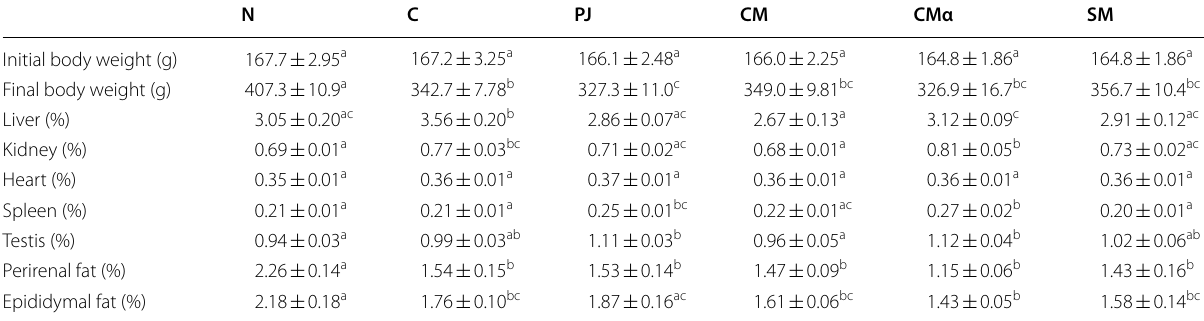
N, normal; C, control; PJ, Psoroglaena japonica ; CM, Cordyceps militaris ; CMα, cordycepin-rich C. militaris ; SM, syrimarin 1 The relative weight of the tissue (%) represents the ratio of the tissue weight to the body weight